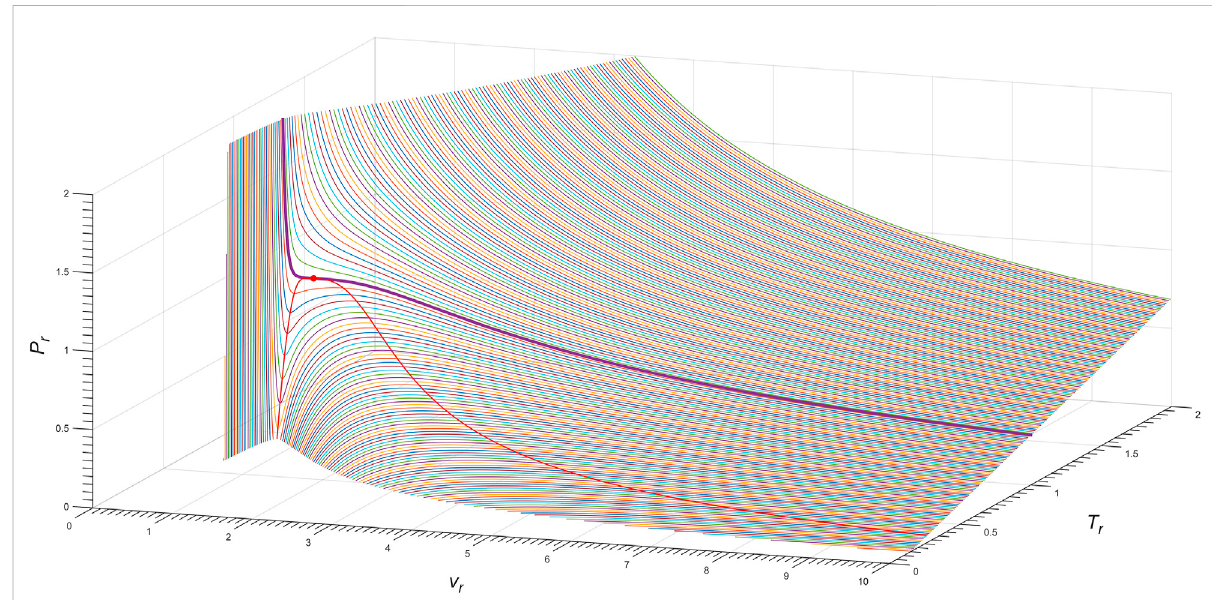
FIGURE 6 Three-dimensional P r − v r − T r phase diagram of the exact n = 2 Janus van der Waals Eq. 7, as for the cyclopentane molecule (C 5 H 10 ). The bold purplelinecorrespondstotheisothermof T r =1.00,asdepictedinFigure5B;theredlineistheJanusvanderWaalsspinodalcurvewith a =0.99;and the red dot is the critical